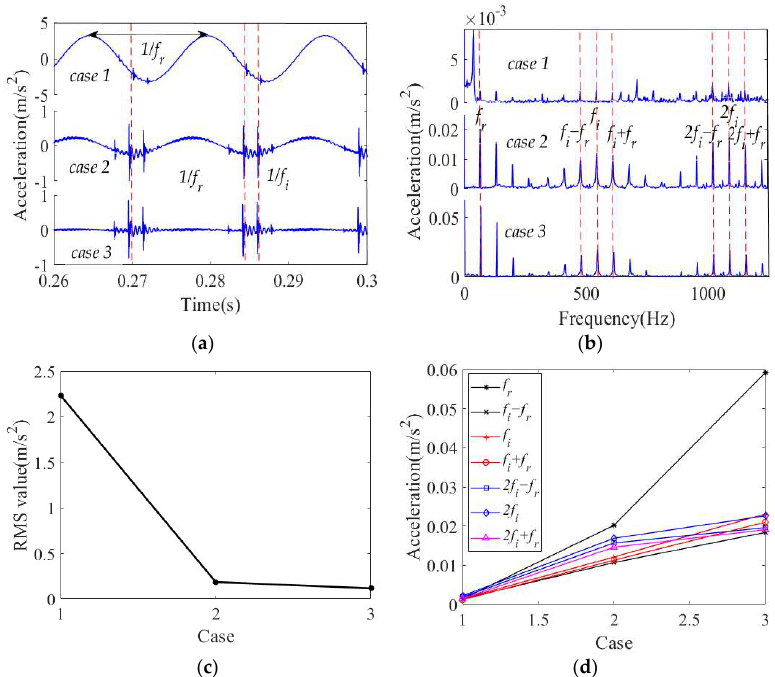
Figure 9. The time-domain and frequency responses of the bearing housing under inner ring defect and different housing stiffness: ( a ) acceleration signals; ( b ) envelope spectrum; ( c ) RMS; ( d )